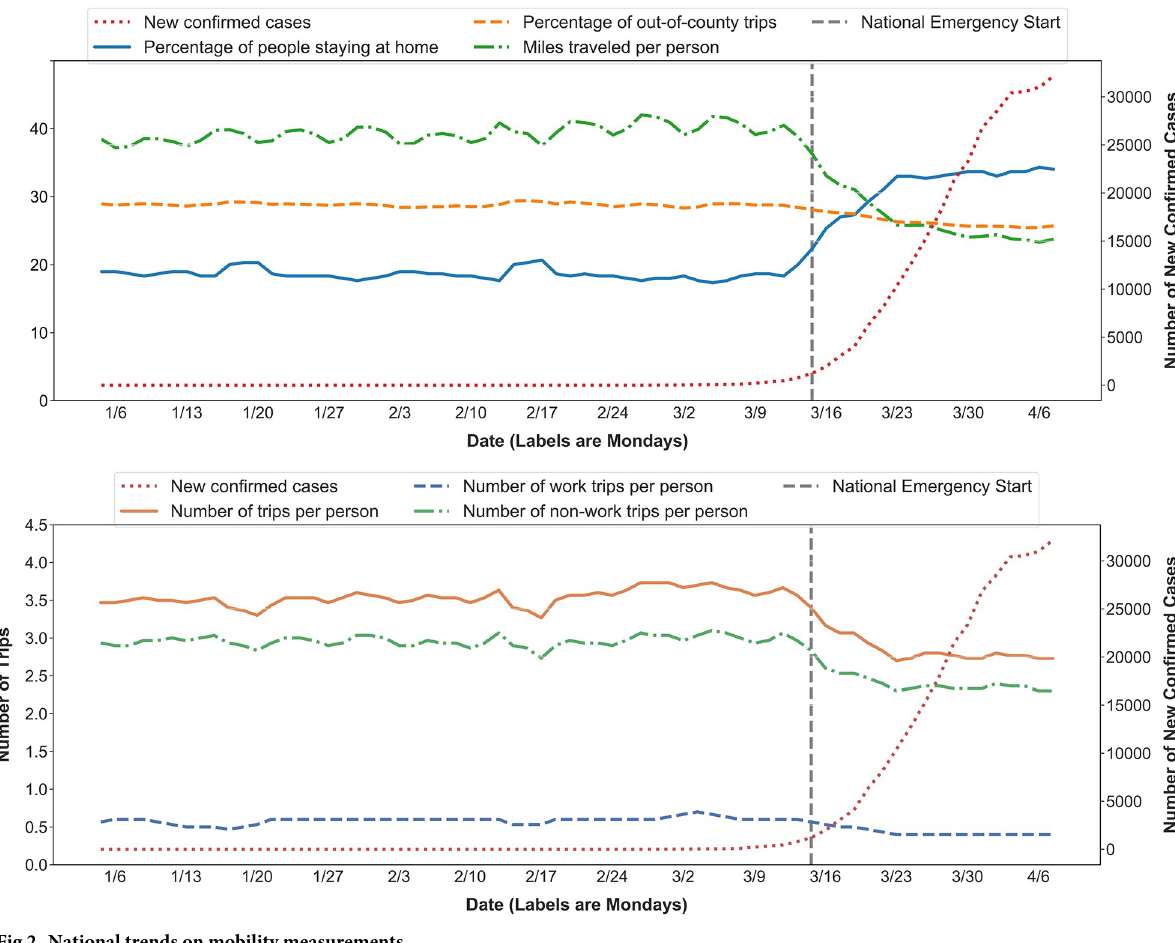
Fig 2. National trends on mobility